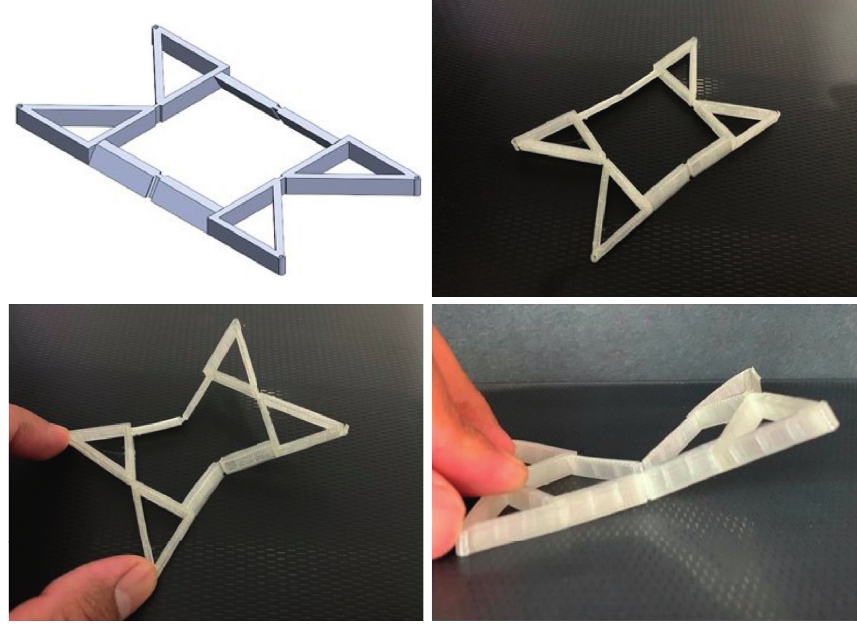
Figure 9: CAD design and mechanism 3D printed in TPU.